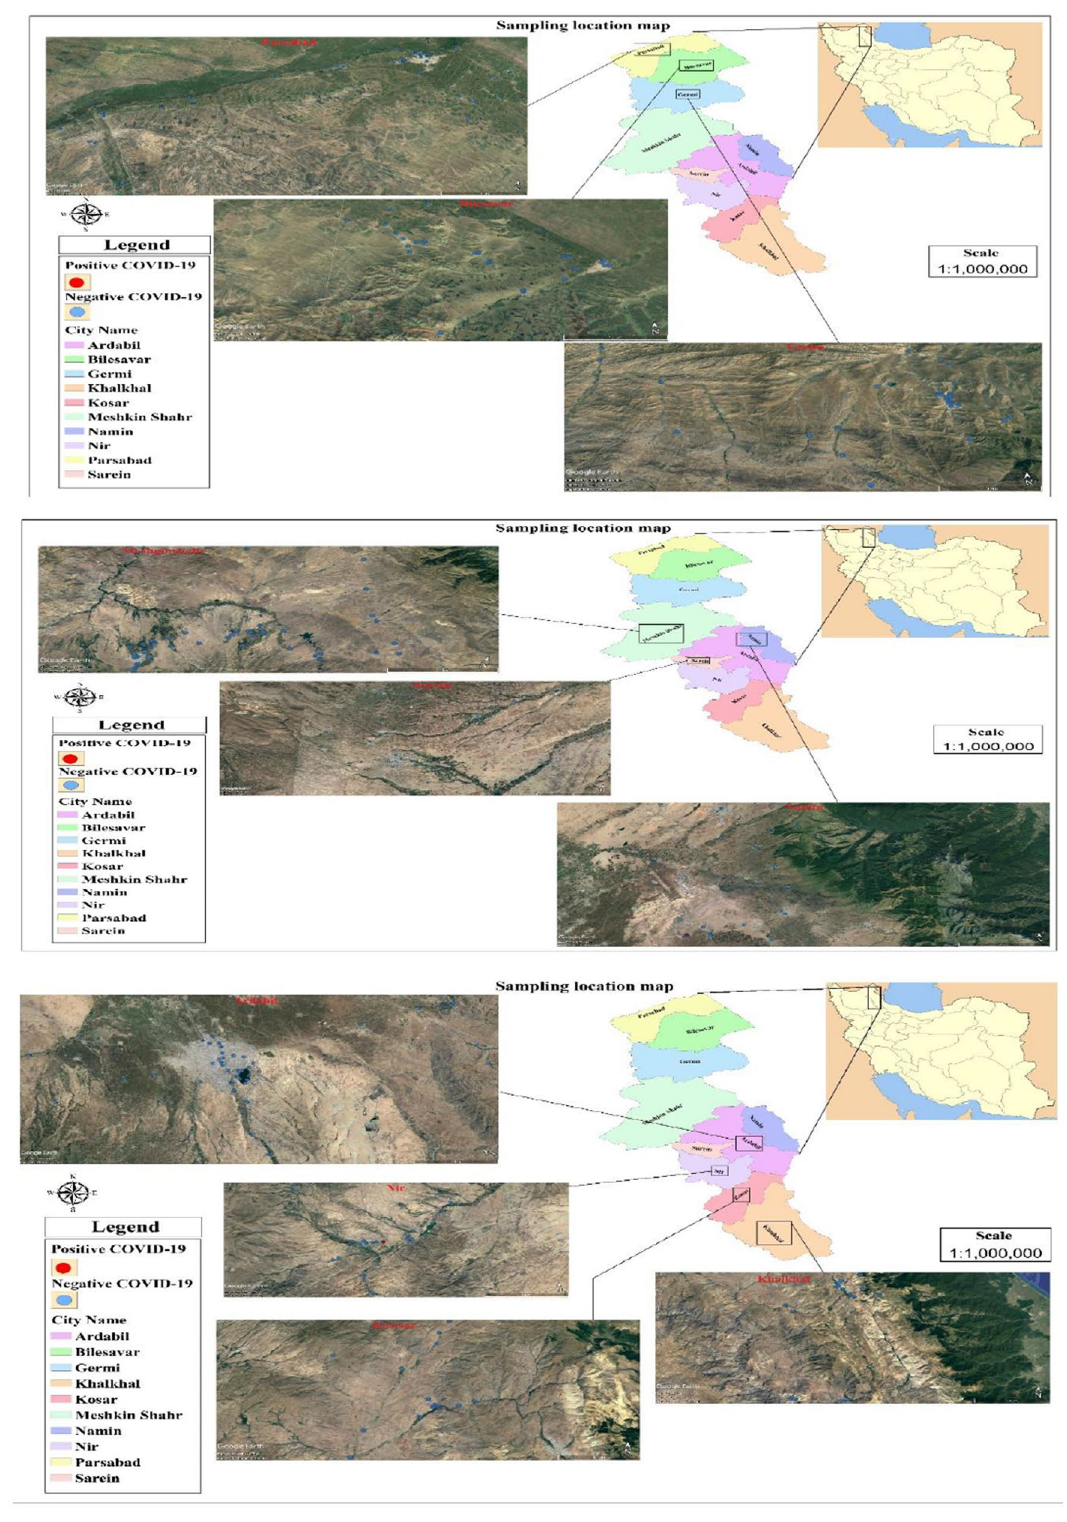
Fig. 1 Position of different sampling points in this